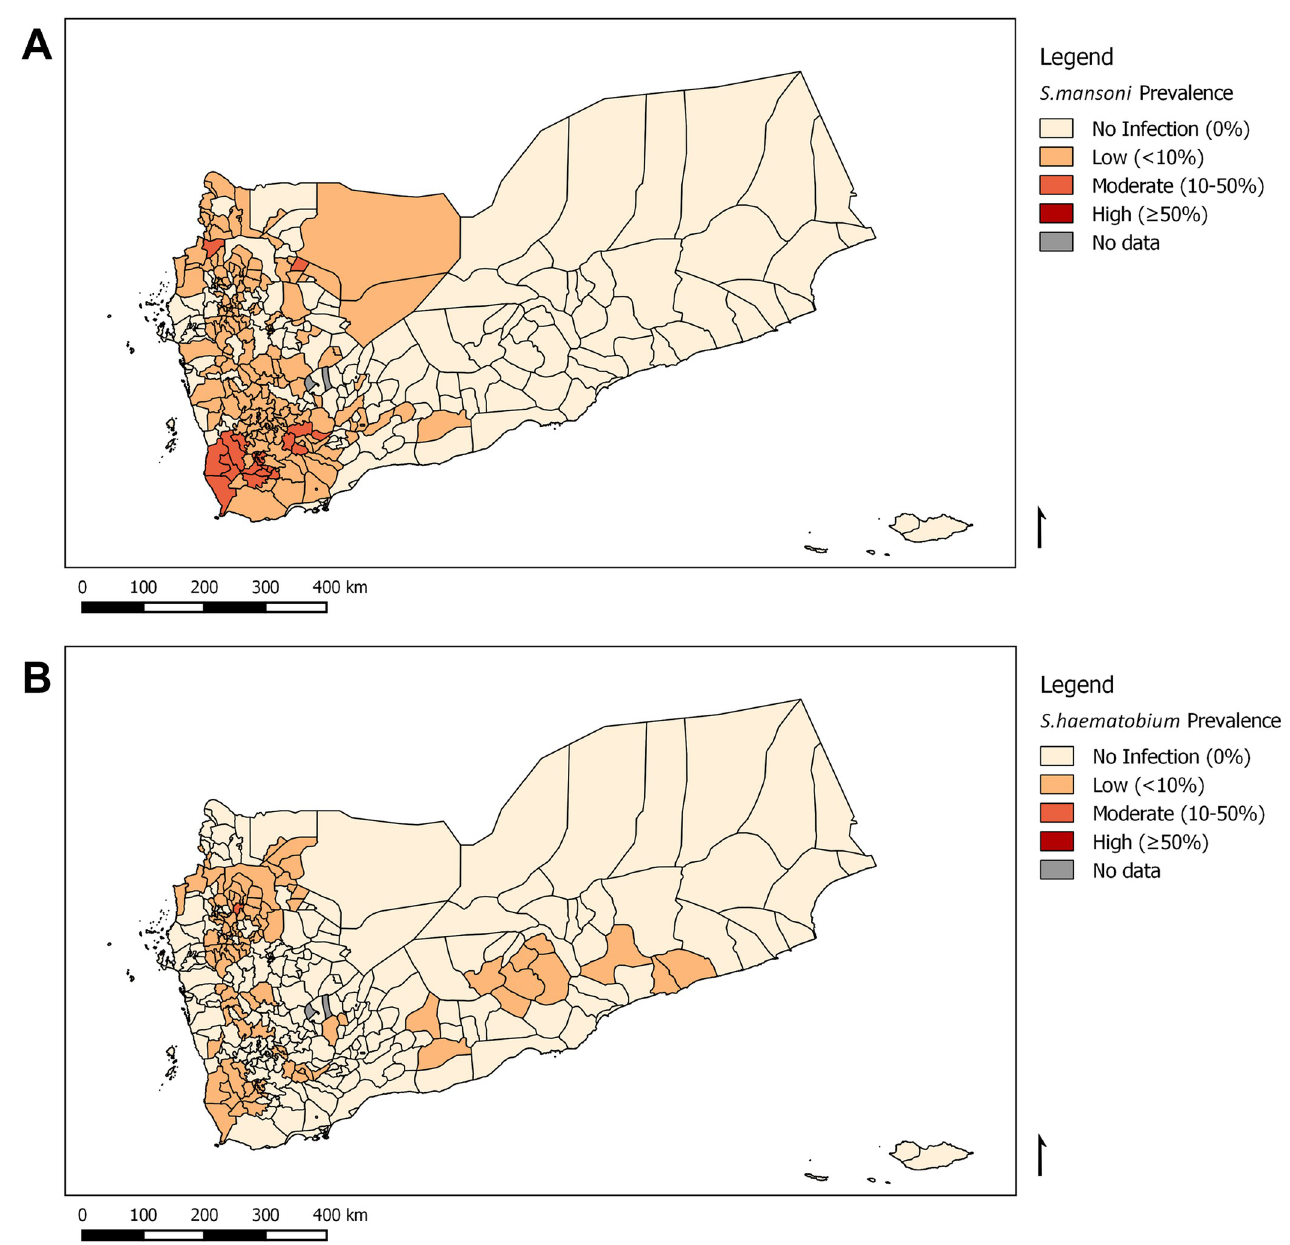
Fig 1. District-level prevalence maps of schistosomiasis infection in Yemen, 2014. (A) Intestinal ( Schistosoma mansoni ) and (B) Urogenital ( S . haematobium ) schistosomiasis. These figures were created for this manuscript in QGIS using open source data from DIVA-GIS for the base layers. (DIVA-GIS-http://www.diva-gis.org/gdata). About two-thirds (65.4%) of the Yemeni districts were classified as having either low or moderate risk of Ascaris infection. Fig 3B shows the district-level point prevalence of Ascaris infection at the district level. About a fifth (21.7%) of Yemeni districts have Ascaris infections among 20%-50% of schoolchildren. Based on the WHO classification [12, 21], nine districts are in the high-risk category, with more than 50% of schoolchildren infected with Ascaris (Table 4). Trichuriasis was the second most common STH: 133 districts (40.1%) were classified